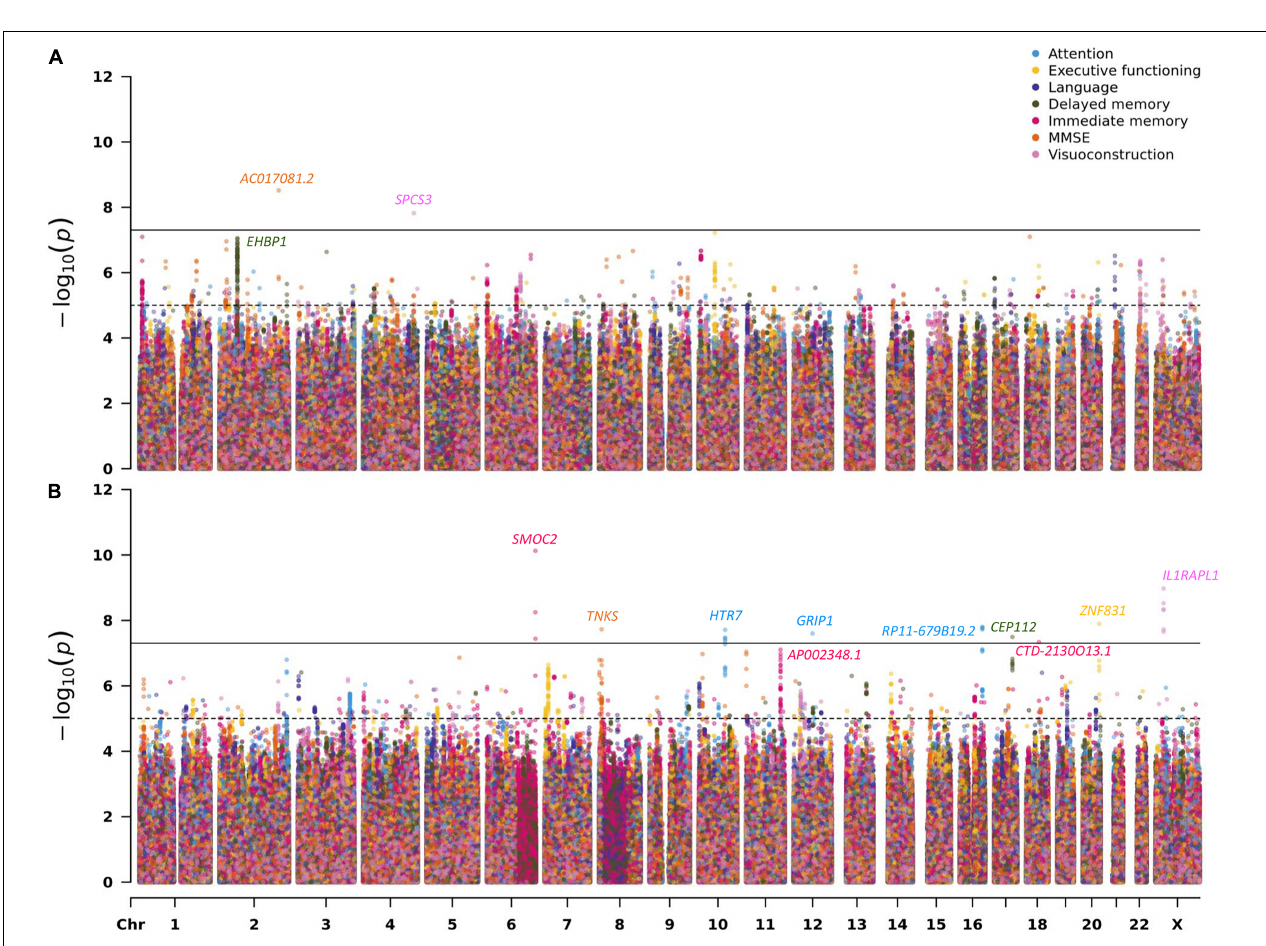
FIGURE 1 | Multi-trait Manhattan plots for the SNP-based GWAS results on neuropsychological phenotypes ( A: cross-sectional; B: longitudinal). For details on the analyzed traits see section “Materials and Methods” and Supplementary Material .